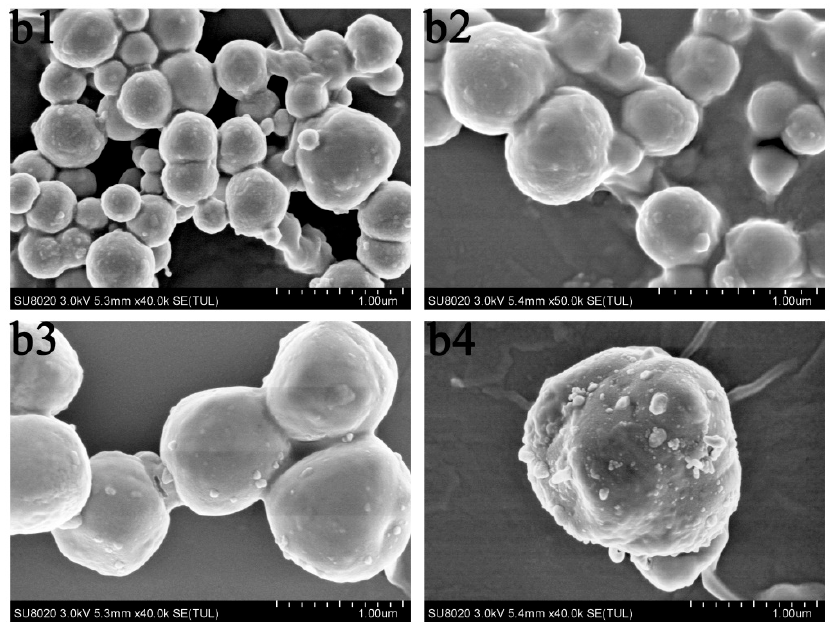
Figure 3. Micrographs of the prepared samples with beeswax with different concentrations of AgNO 3 .